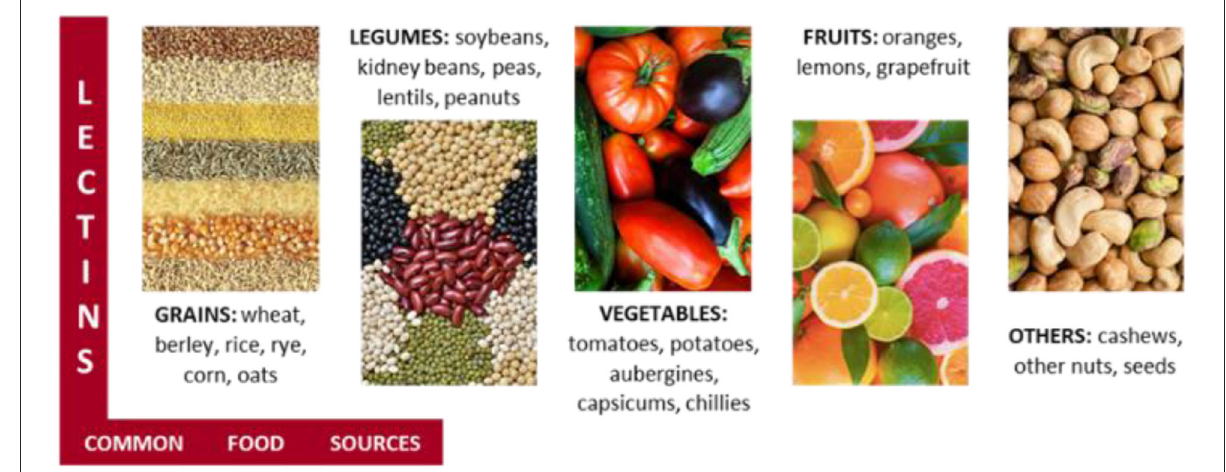
FIGURE9 Food sources of anti-nutrient lectins may negatively impact gut permeability and alter the population of good microbiota. Mushrooms’ lectins, however, show potential for treating several ailments.